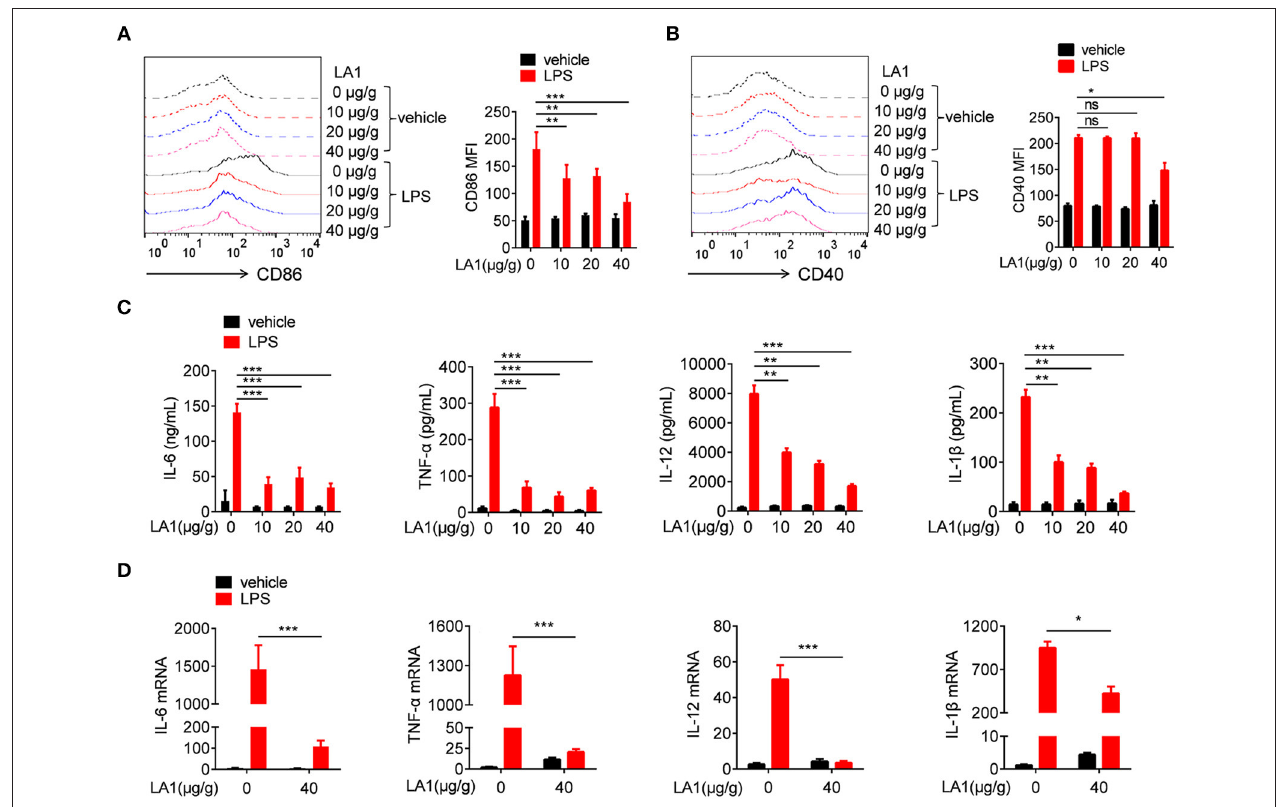
FIGURE 3 | Activation of CD11b by LA1 inhibited LPS-induced pro-inflammatory response in macrophages in vivo . C57BL/6 mice were treated with either LA1 (10, 20, and 40 µ g/g of body weight) or vehicle for 2h, and then, stimulated with LPS (10 µ g/g of body weight). FACS analysis was performed to assess the expressions of CD86 (A) and CD40 (B) in splenic macrophages after 12h. Levels of IL-6, TNF- α , IL-12, and IL-1 β in serum were determined by ELISA after 6h (C) . The expressions of IL-6, TNF- α , IL-12, and IL-1 β (D) in peritoneal cells were examined by qRT-PCR after 6h. Data are shown as the means ± SEM ( n = 6 replicates) and are representative of three independent experiments. Error bars represent S.E.M. * p < 0.05, ** p < 0.01, *** p < 0.001, as determined by two-way ANOVA post-hoc Bonferroni Multiple Comparison Test; ns denotes p >